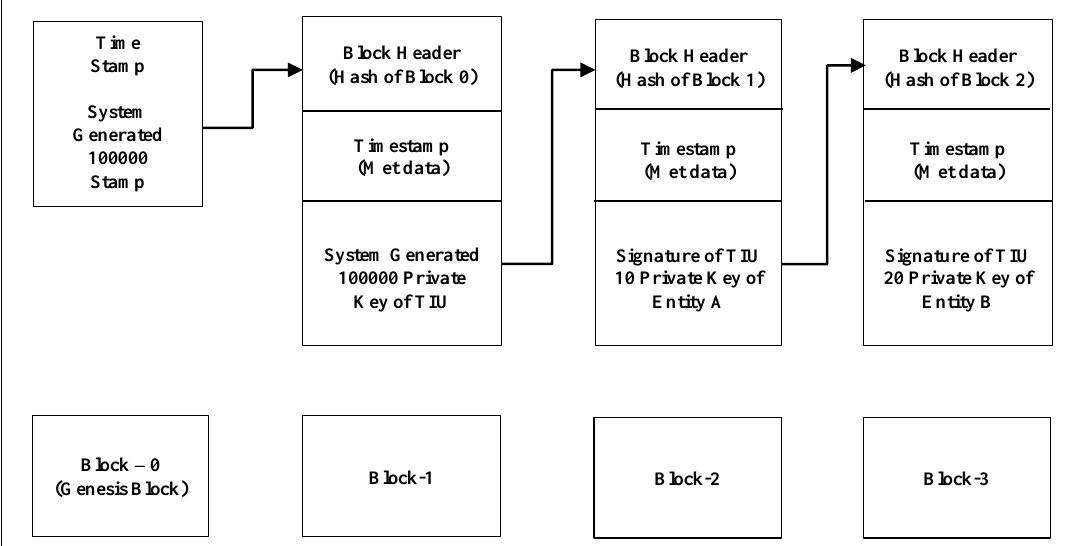
Figure 3. Blockchain Diagram for Time-stamped and Encrypted